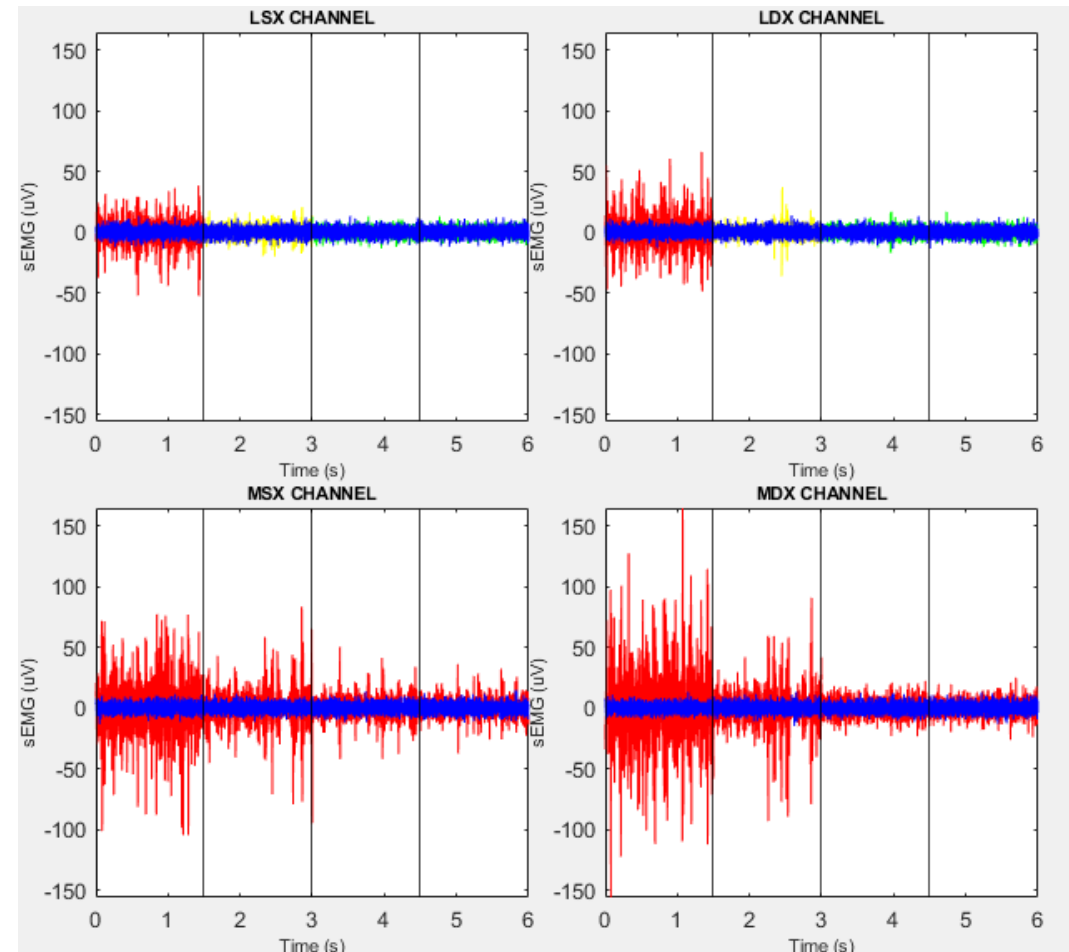
Figure 11. Superimposition between sEMG full-flexion signals of ID2 and ID4. The blue signals in front refer to the ID2 (gold standard (GS)), while the others on the back refer to ID4 (LBP patient). The sEMG signal of the LBP patient is in red when the mean RMS value, on the 10 segments represented in Figure 7 Step 6, is outside the FRP validity range; in green when all sEMG RMS values on the segments are in the validity range; in yellow if there is one or more segments with an outer value with respect to the validity range, but the overall mean on the 10 segments is inside the range.